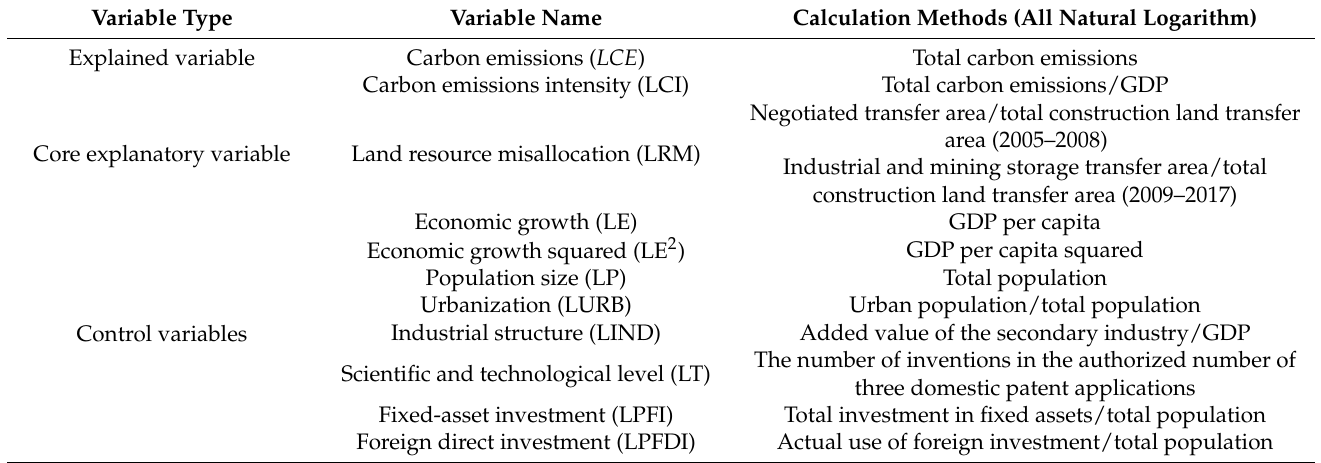
Table 2. Connotations of the